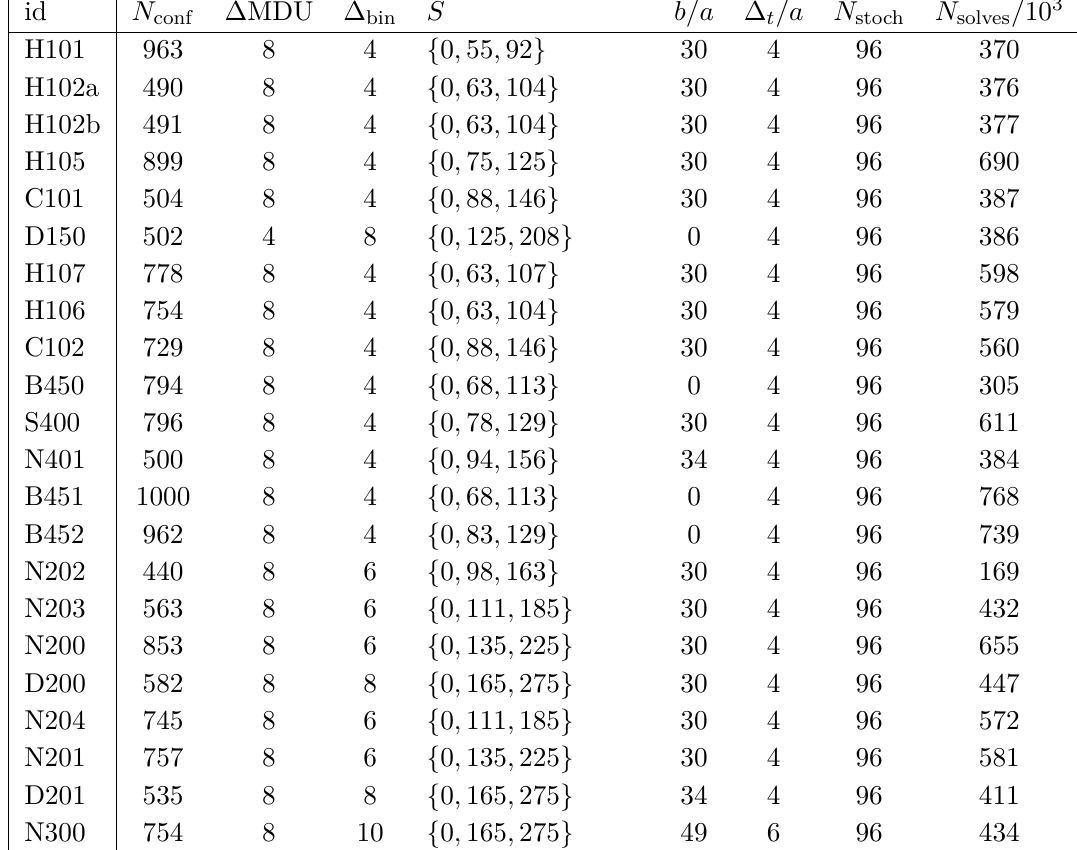
Table 3. Parameters related to the measurement of the correlation functions: the number of analysed configurations N conf , their separation in molecular dynamics units ∆MDU , the choice of binning ∆ bin to account for autocorrelation effects in the statistical analysis, the numbers of smearing iterations s ∈ S , the distance from the temporal boundaries b (in the case of open boundary conditions) and the time partitioning separation ∆ t . In the last column we display the total number of individual Dirac vector solves carried out on each ensemble to compute the disconnected correlation functions. The number of solves needed for the connected part is much smaller (72: 2 quark masses × 3 smearing levels × source spin-colour). Ensembles H102a and H102b were generated with the same quark masses and lattice coupling but different simulation parameters and are therefore analysed